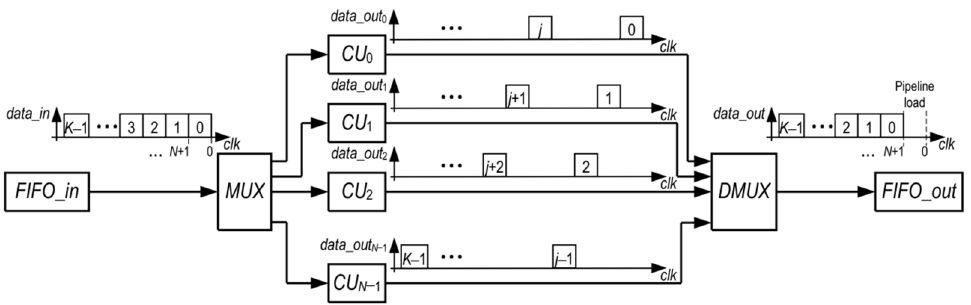
Figure 2. A scheme of the pipelined data processing mode.